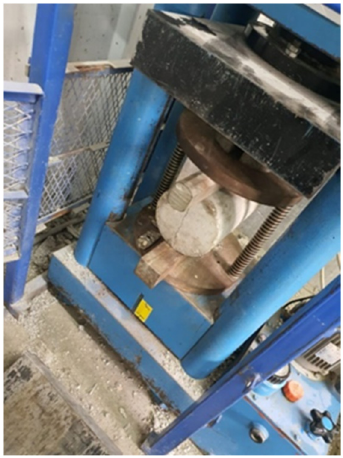
Figure 5. Split tensile strength test.